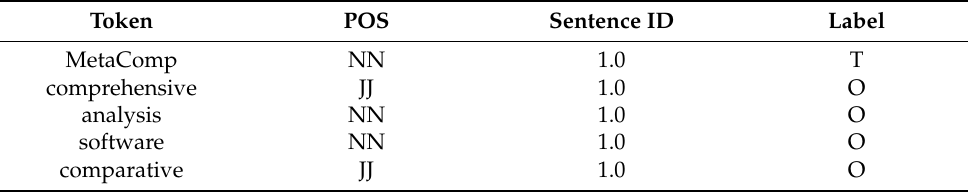
Table 5. Example of processed training data. Where each row corresponds to a word from the collection of abstracts in the training data. The Part of Speech column (POS) tag tokens as a common noun (NN), adjective (JJ), etc. The sentence ID column identifies a training example (i.e., all tokens with the same Sentence ID are inserted into the model as one training example. The label column describes whether a token is a software tool (T) or not